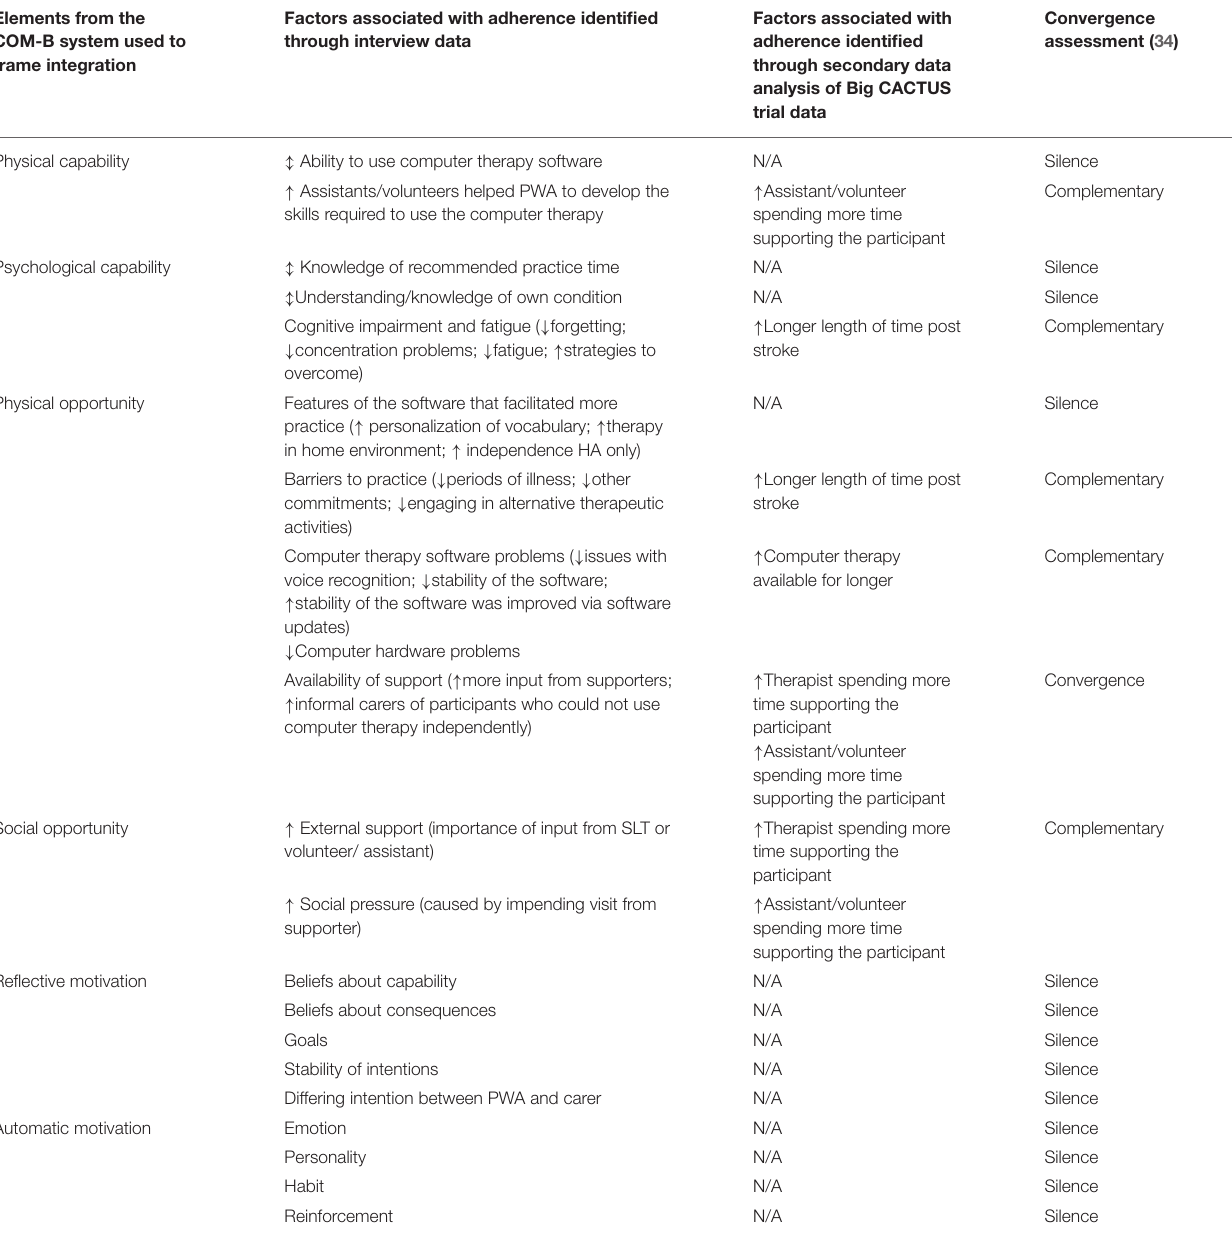
TABLE 5 | Convergence coding matrix. Elements from the COM-B system used